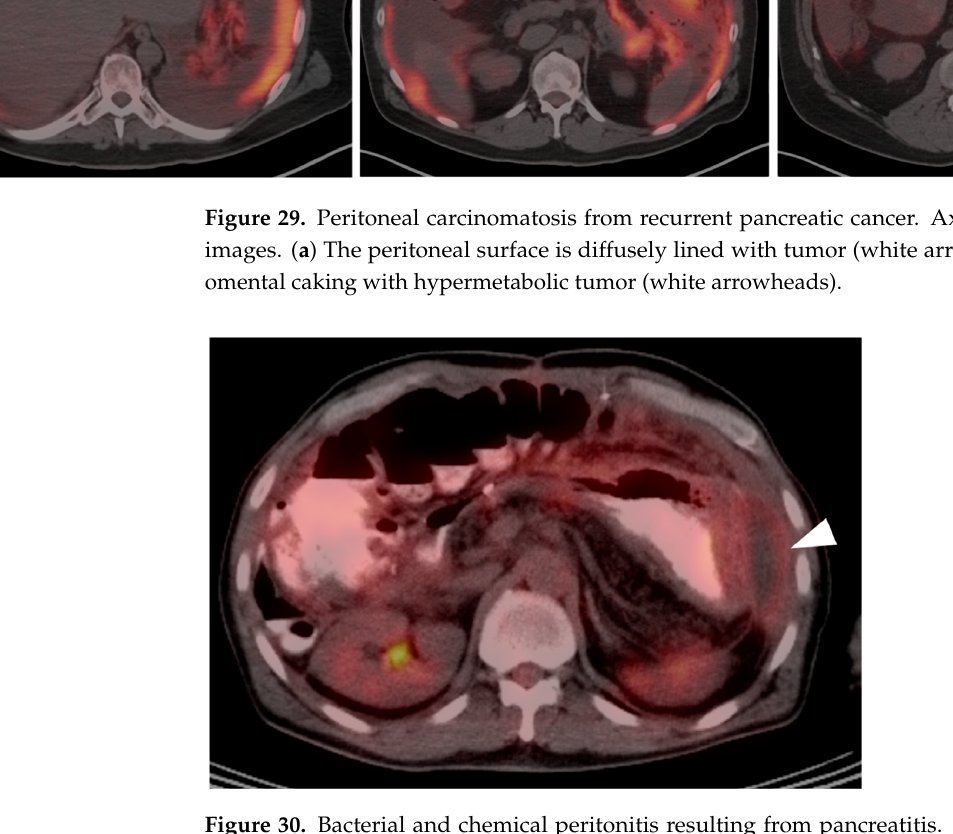
Figure 30. Bacterial and chemical peritonitis resulting from pancreatitis. On an axial fused PET-CT image, diffuse metabolically active tissue is present throughout the peritoneal space with fluid col-